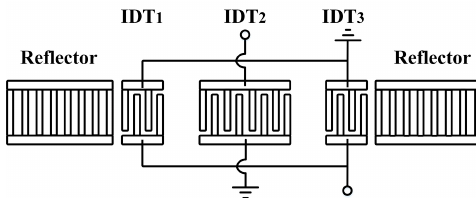
Figure 9. Schematic of a three-transducer-structure surface acoustic wave (SAW) resonator.